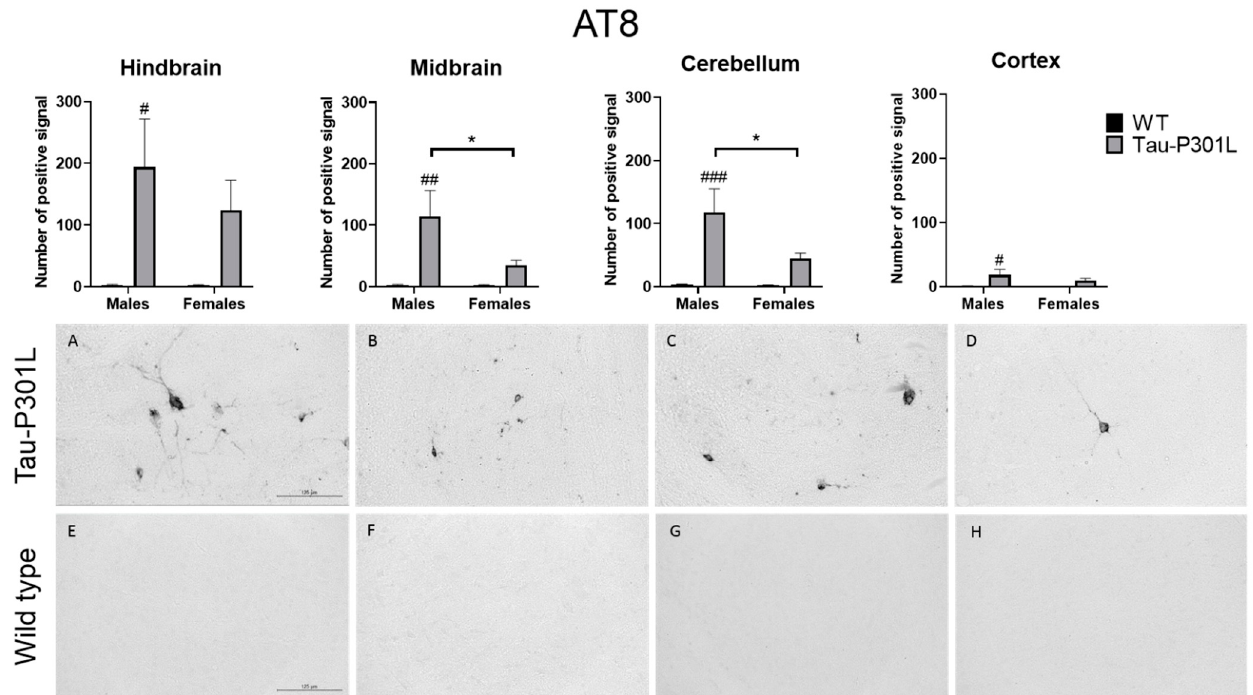
Figure 7. Tau-P301L mice show pathological Tau in different areas of the brain at 8 months of age. The phosphorylated Tau was detected by AT8 antibody. The hindbrain ( A , E ), cortex ( D , H ), midbrain ( B , F ) and cerebellum ( C , G ) from Tau-P301L ( A – D ) and wild type (WT) male mice ( E – H ) were analyzed. The positive signal was counted at different regions of the brain using ImageJ software. A two-way ANOVA was used for analysis. *: p < 0.05; #: p < 0.05, ##: p < 0.01 and ###: p < 0.001 compared to sex-matched WT. Scale bar is 125 µm.